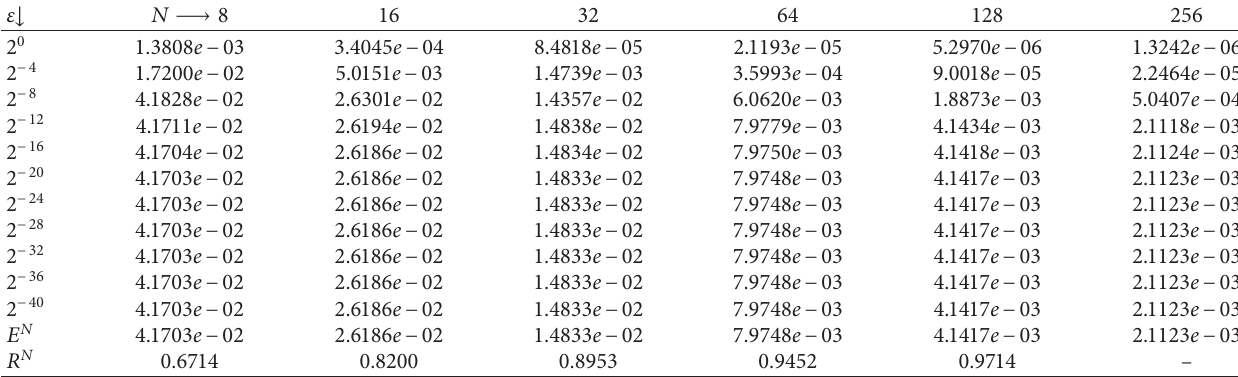
Table 1: Maximum absolute error of Example 1 before Richardson extrapolation for δ � 0 . 6 ε ​ and η � 0 . 5 ε .